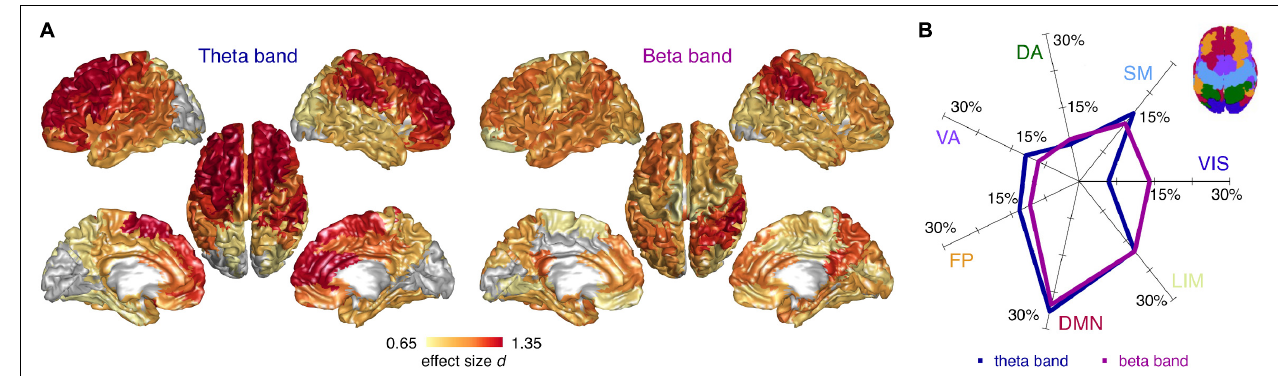
FIGURE 3 | Cortical distribution of spectral differences between cognitively normal and impaired subjects. (A) Cortical surface plots of local effect size (Cohen’s d ) for statistically significant ( FDR < 0.05) CI-CN comparisons of source relative band power (RBP), in the theta and beta frequency band (ANCOVA analyses including age and gender covariates). Cortical regions not surviving multiple comparison correction are represented in gray. (B) Percentage effect size contributions in the 7 RSNs, for the theta and beta RBP. The percentage effect size contribution for each RSN was assessed by normalizing the effect size sum over the regions belonging to each RSNs by the sum of all regions’ effect size, and considering only the regions significantly different between cognitively normal and impaired subjects. Inset: schematic representation of the 7 RSNs on the cortical surface. VIS, visual; SM, sensorimotor; DA, dorsal attention; VA, ventral attention; FP, fronto-parietal; DMN, default mode; LIM, limbic